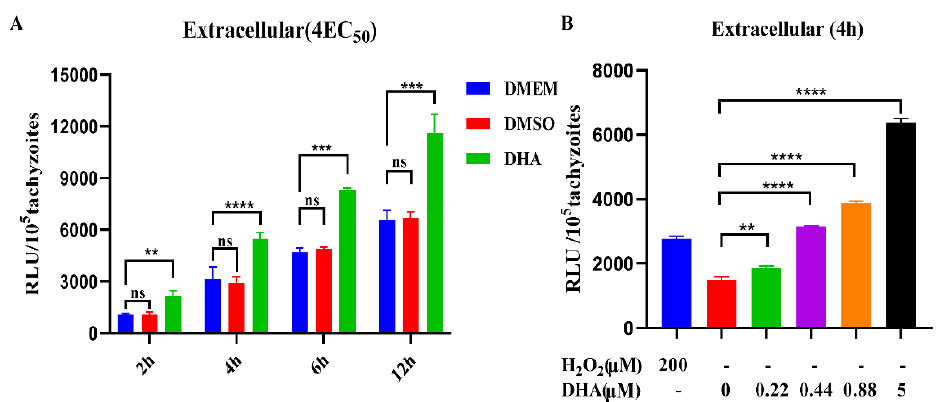
Figure 2. DHA-induced dose-dependent ROS production in tachyzoites. ( A ) ROS levels of parasites after different times of DHA treatment. Fresh extracellular tachyzoites were collected and incubated with 0.88 µ M DHA at 37 ◦ C for 2, 4, 6, and 12 h, respectively. Then, RLUs of tachyzoites in each sample were detected using the DCFDA probe. DMSO was treated as a control. ( B ) Effect of different DHA concentrations on ROS levels in extracellular tachyzoites. Fresh extracellular tachyzoites were incubated with 0 to 5 µ M DHA or DMSO at 37 ◦ C for 4 h, and then RLUs were detected. H 2 O 2 (200 µ M) was used as a positive control. Statistical analysis was performed using Student’s t -tests; ns, not significant; ** p < 0.05, *** p < 0.01 and **** p < 0.001. Three independent experiments were performed.